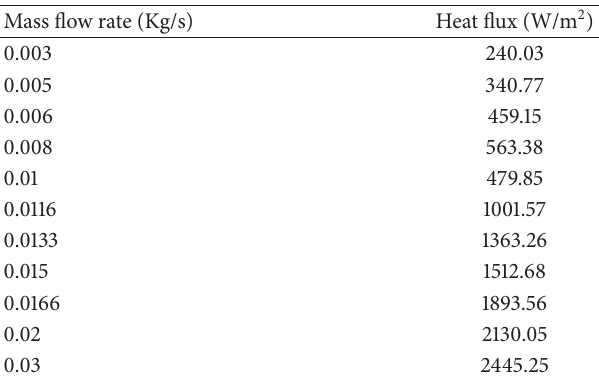
Figure 3: Grid for the plain tube fitted with V-cut twisted (VCT) tape insert.